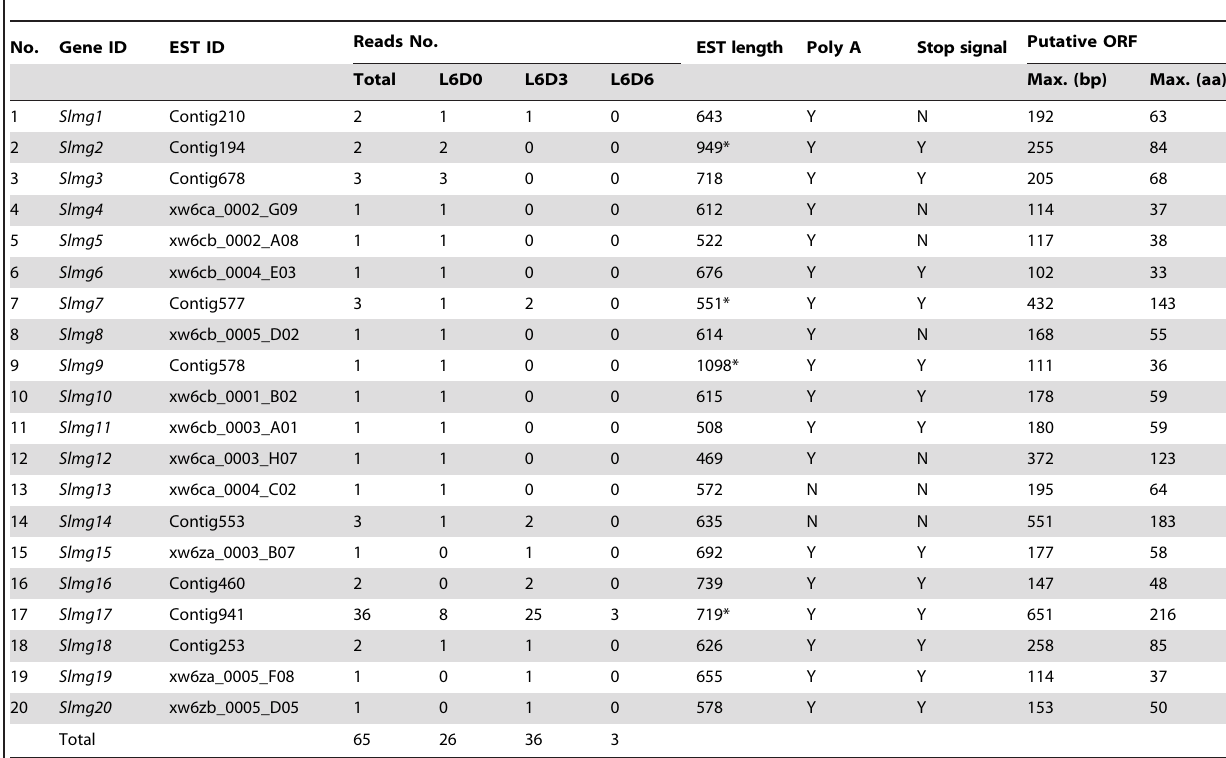
Table 3. Analysis of the selected 20 ESTs of Spodoptera litura